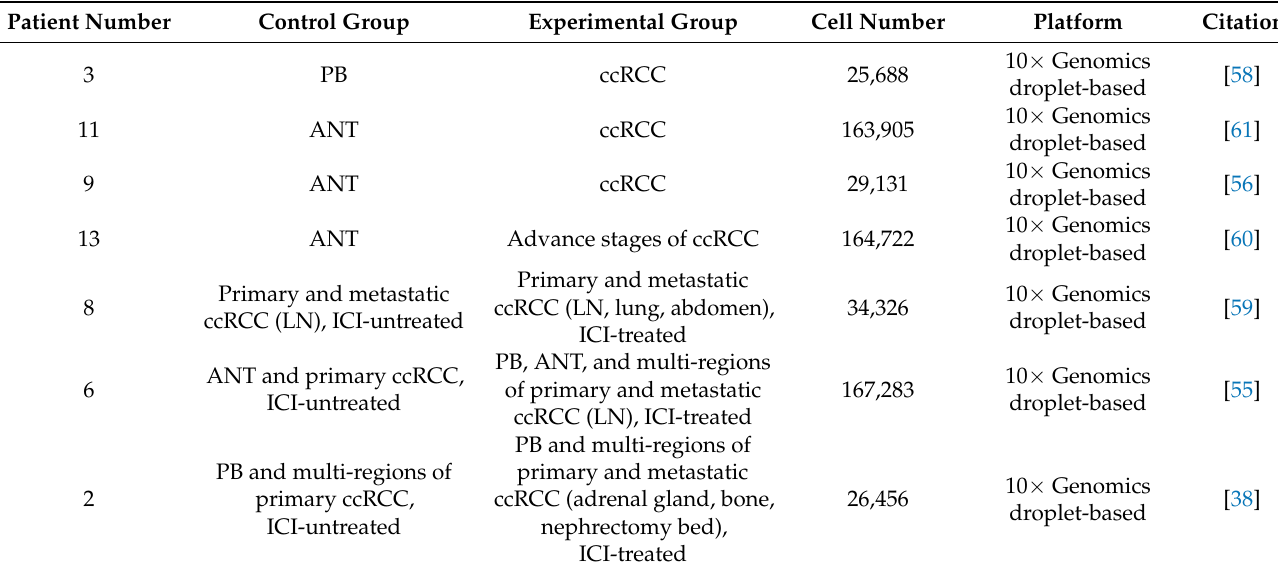
Table 3. scRNAseq studies identifying and characterizing immune environment associated with ccRCC progression and response to